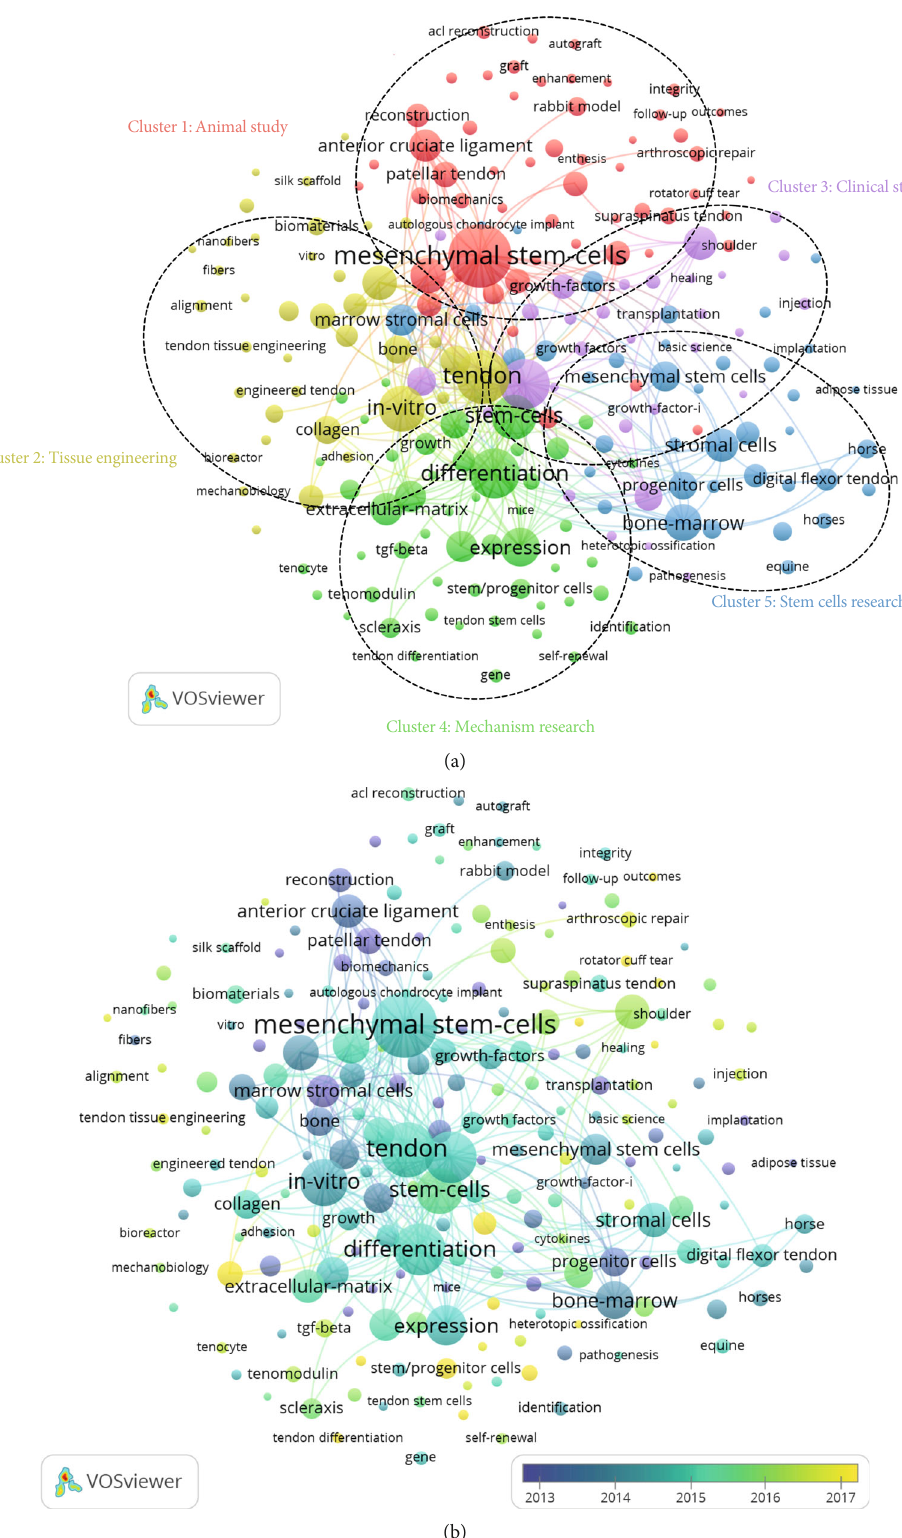
Figure 6: Cooccurrence analysis of global research of tendon stem cells. (a) Mapping on keywords in the research of tendon stem cells; the size of the nodes indicates the frequency, and the keywords are classi fi ed into fi ve clusters: animal study (red color), tissue engineering (yellow color), mechanism research (green color), stem cell research (blue color), and clinical study (purple color). (b) Distribution of keywords based upon their time of appearance; purple keywords appeared earlier than green ones, and yellow keywords appear later than both of purple and green